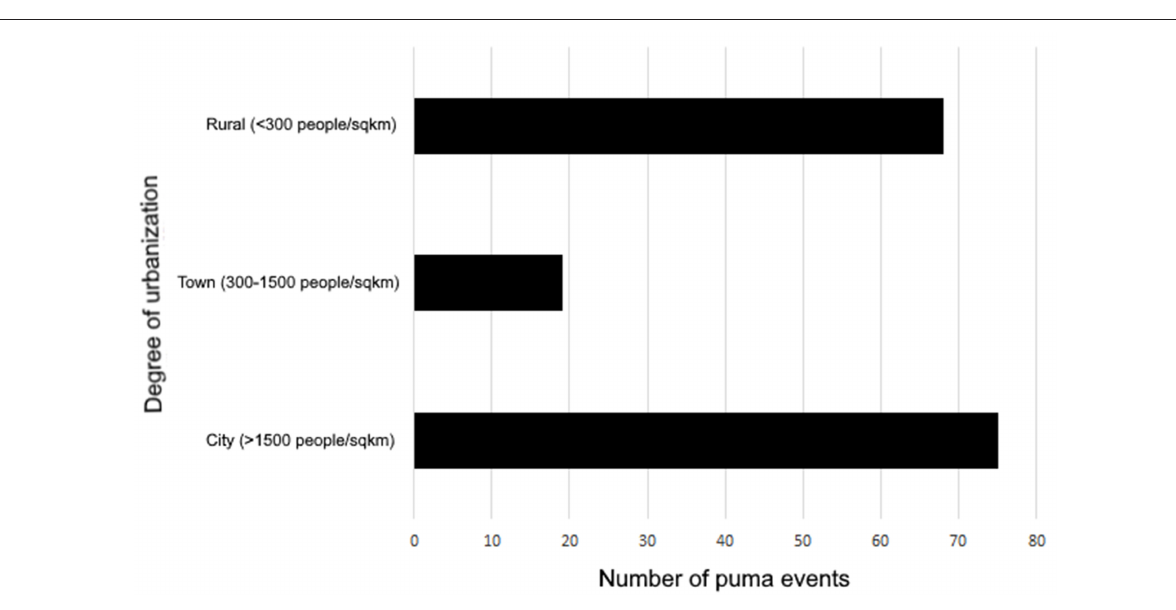
FIGURE 6 | Amount of puma events according to the “urbanization